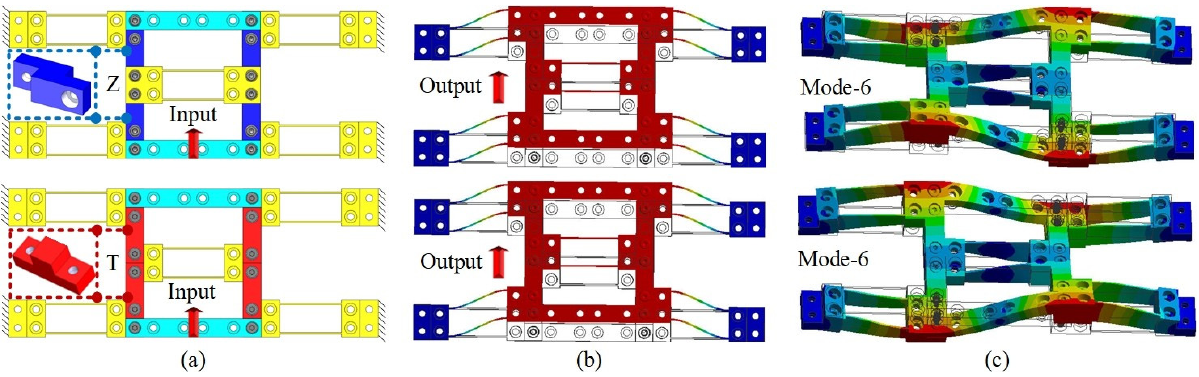
Figure 6. Comparison of Z-type and T-type connection modules: ( a ) guiding mechanisms assembled with Z-type and T-type connection modules; ( b ) static simulation; ( c ) dynamic simulation. Table 1. Deviation between the ZTCM-based mechanism and the TTCM-based mechanism of static performance and dynamic performance.